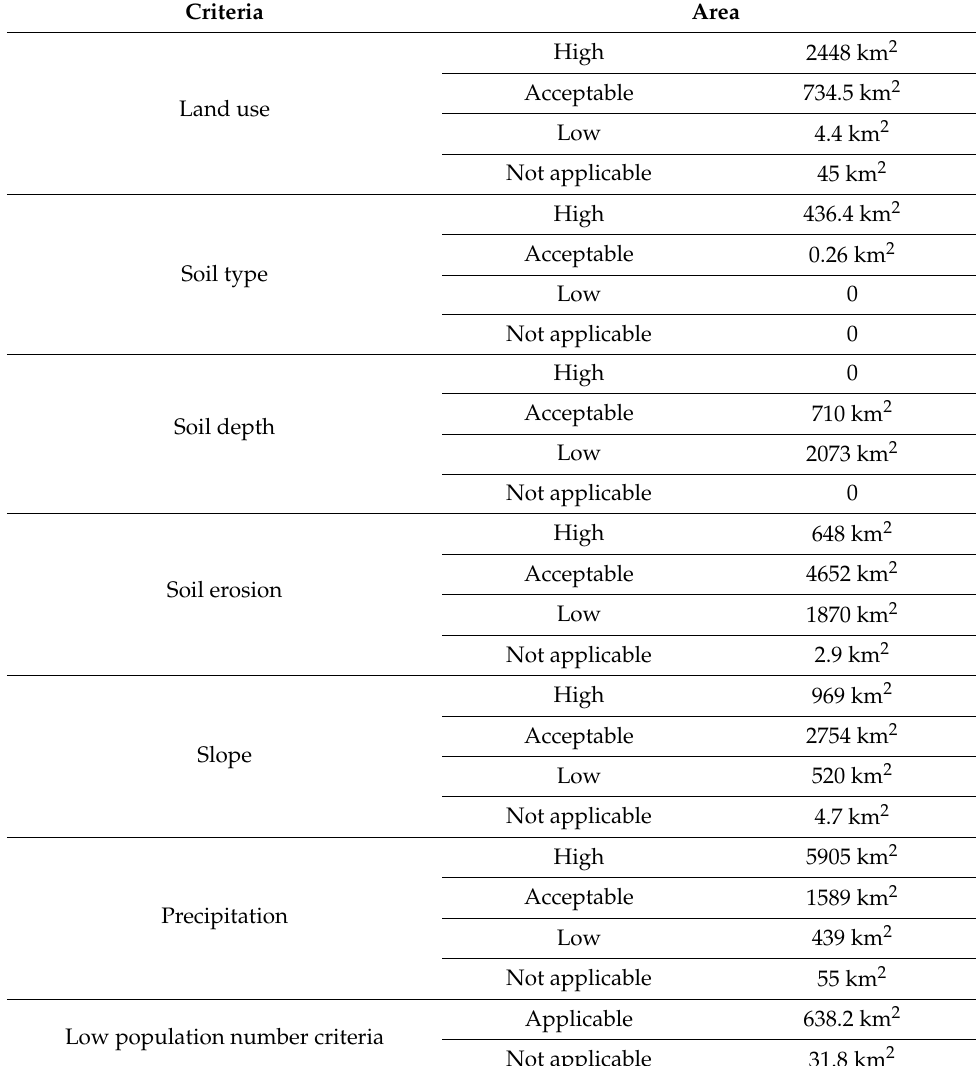
Table 3. Fuzzy set memberships, membership functions and areas used for BWWT plants in the Litani River